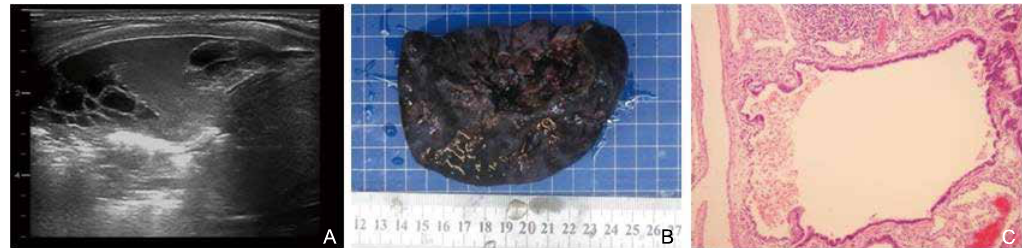
Figure 1 Ultrasonography and pathologic manifestations in type 1 CPAM: (A) A cystic mass contained several septa, which divided the cystic mass into several cystic cavities, 1–5 cm in diameter. The cystic wall was thickened, and there were dense, dot-like echoes in some cystic cavities. (B) Gross photo of resected specimens. (C) Microscopy showing big cyst (bronchiole like) surrounded by small cysts, lined by stratified columnar epithelium and having thin fibromuscular septa.